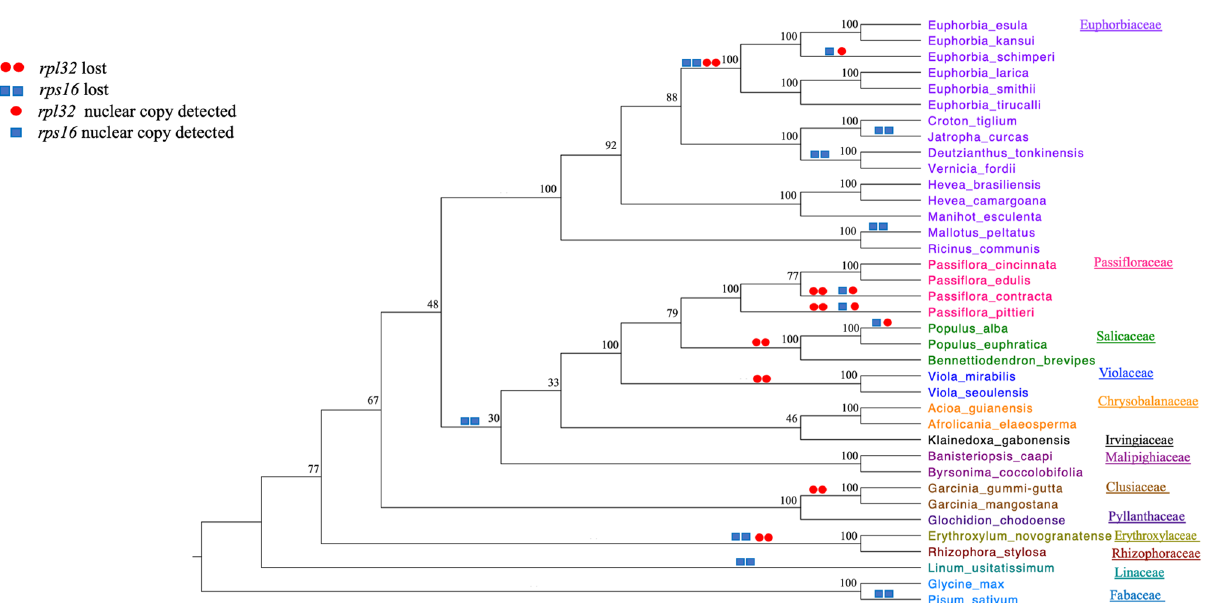
Figure 5. ML cladogram of 37 taxa (Supplemental Table S2) based on 45 plastid gene sequences (Supplemental table S3). Numbers at node are bootstrap (Fig. 5). These changes were plotted based on the results of this study and previously published studies, including examination of the plastome sequences on GenBank (Supplementary Table S2). The results indicated that five genera of Euphorbiaceae have representative species that lost rps16, Deutzianthus , Euphorbia , Jatropha , Mallotus and Vernicia, and one genus ( Euphorbia ) also lost rpl32 (Fig. 5) . Since all Euphorbia plastomes do not have intact rpl32 or rps16 these losses likely occurred during the early divergence of the genus. However, the presence of these genes in the nucleus by either a transfer or substitution event has only been documented in E . schimperi . Some members of other Malpighiales families have experienced the loss of rpl32 and/or rps16 from their plasto- mes, including Passifloraceae, Salicaceae, Violaceae, Erythoxylaceae and Rhizophoraceae, whereas Chrysobala- naceae, Irvingiaceae, Malpighiaceae and Linaceae are missing only rps16 and Clusiaceae is missing only rpl32. The fate of these gene losses has only been determined in Passiflora and Populus with rpl32 transferred to the nucleus and rps16 substituted in selected species in both genera (Fig. 5) 11, 14, 22 .